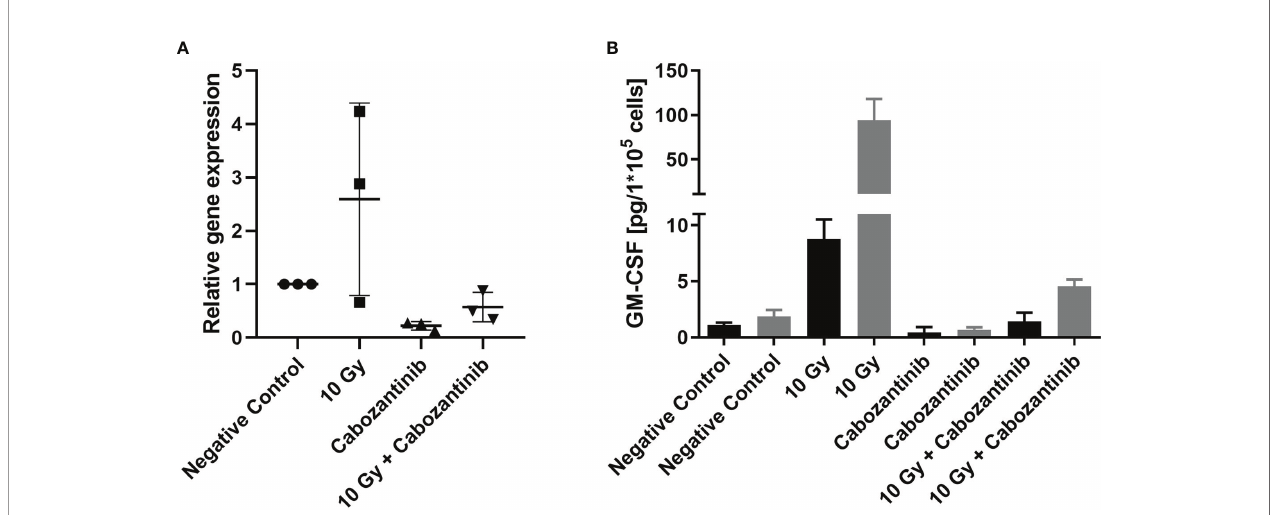
FIGURE 7 | Gene expression and protein release of GM-CSF following treatment. Cells were treated as described with irradiation and/or Cabozantinib. Gene expression analysis 24h after treatment (A) . Data are derived from three independent experiments each and show the n-fold as compared to each negative control. Analysis with a One-way ANOVA revealed no signi fi cant differences between the groups (p=0.0537). Release of GM-CSF measured in the supernatant 24h (black columns) and 48h (grey columns) after treatment (B) . Release of GM-CSF is normalized to the cell number. Data are derived from one experiment carried out in triplicates, which were each measured in technical duplicates. Results were found to be signi fi cant following an analysis using a One-way ANOVA (p<0.0001, for 24h and 48h, both negative controls vs. 10 Gy and 10 Gy vs. 10 Gy +